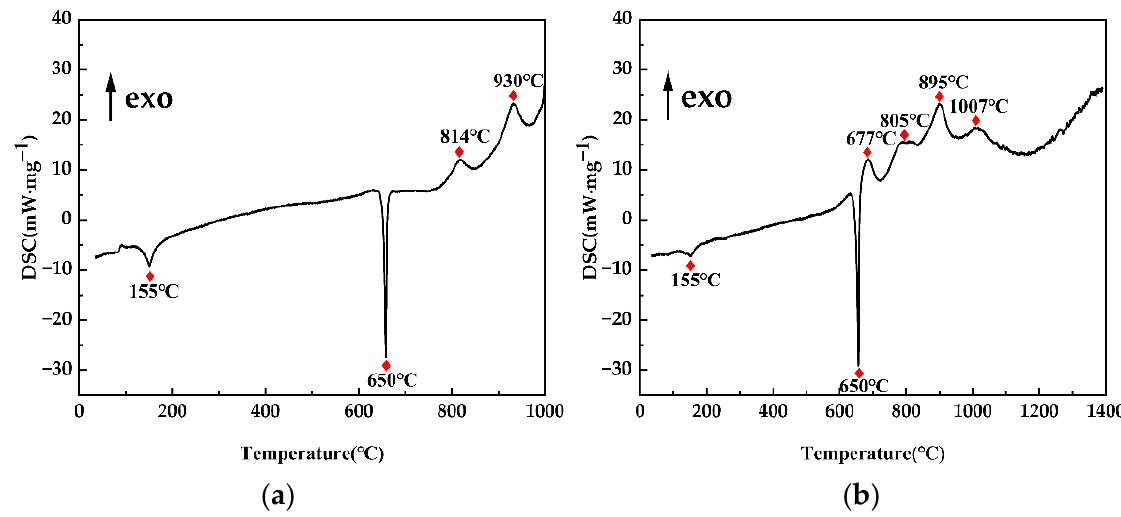
Figure 4. The DSC studies of the reaction systems: ( a ) Al – B 2 O 3 and ( b ) Al – Nb – B 2 O 3 – CuO.